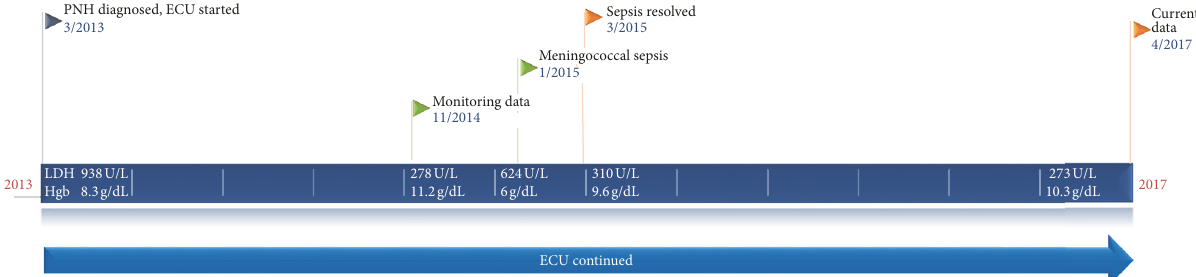
Figure 3: Timeline of events. Dates and events are noted next to flags. Corresponding laboratory values are noted in the rectangular boxes. PNH: paroxysmal nocturnal hemoglobinuria, ECU: eculizumab, LDH: lactate dehydrogenase, and Hgb: